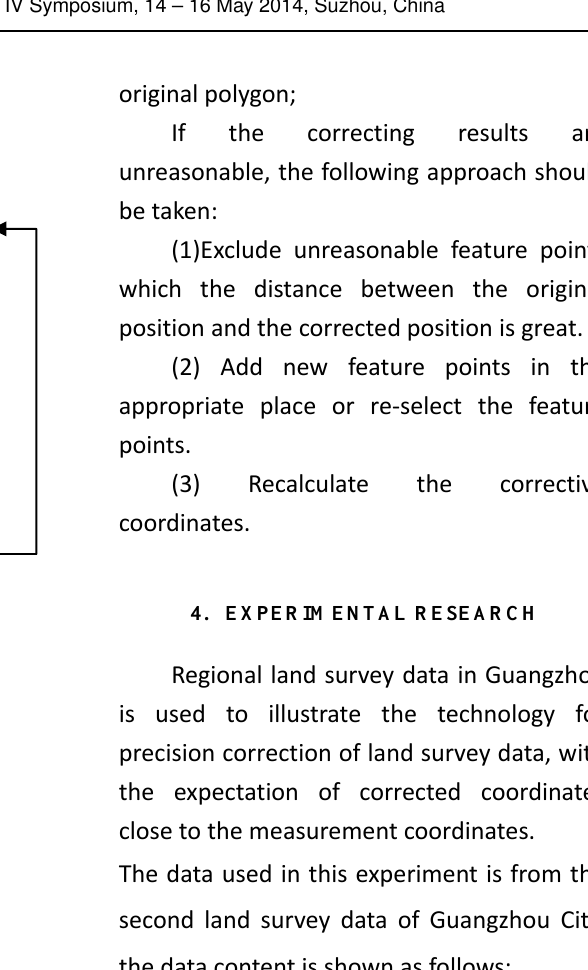
Figure1 flow chart of correction